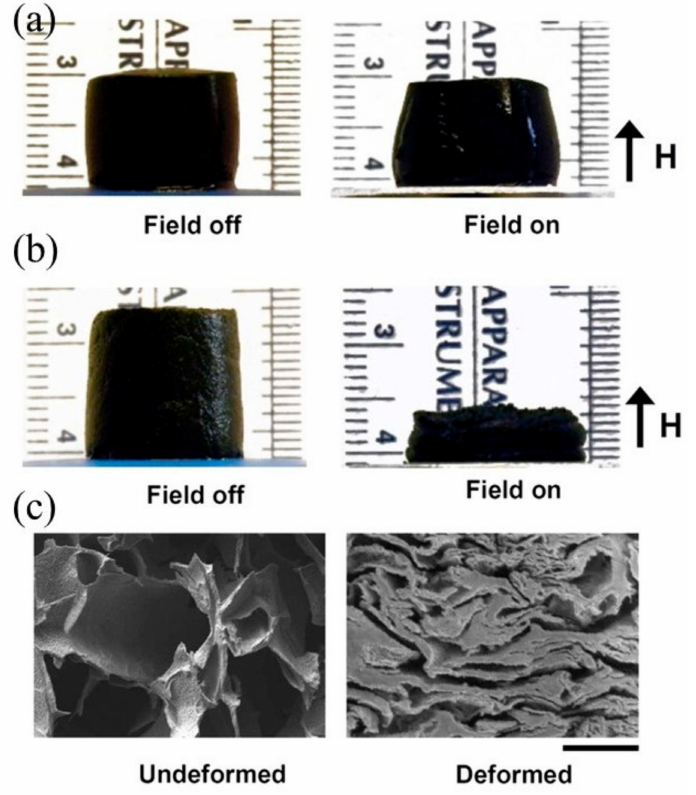
Figure 6. ( a ) A cylinder of a nanoporous ferrogel reduced its height ~5% when subjected to a vertical magnetic-field gradient of ~38 A / m2. ( b ) The corresponding macroporous ferrogel deformed ~70% under the same magnetic field. ( c ) SEM images of a freeze-dried macroporous ferrogel in the undeformed and deformed states. (Scale bar: 500 µ m). Reprinted with permission [112] © 2020 National Academy of Sciences.3.5. Photoresponsive